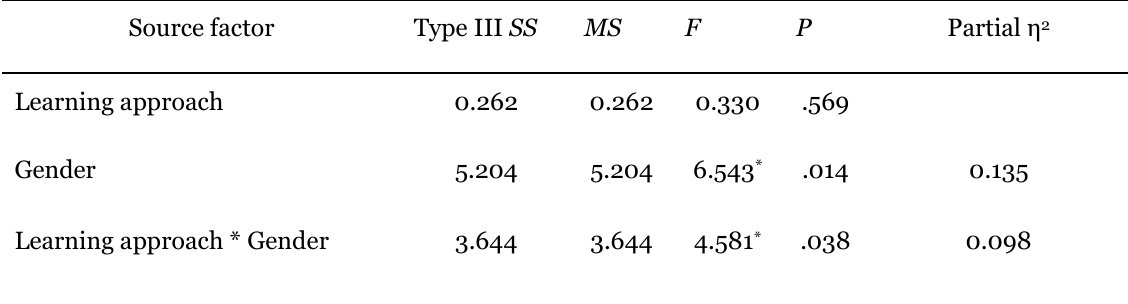
Tests of Between-Subject Effects Measure in the Two-Way ANOVA for VUI Performance